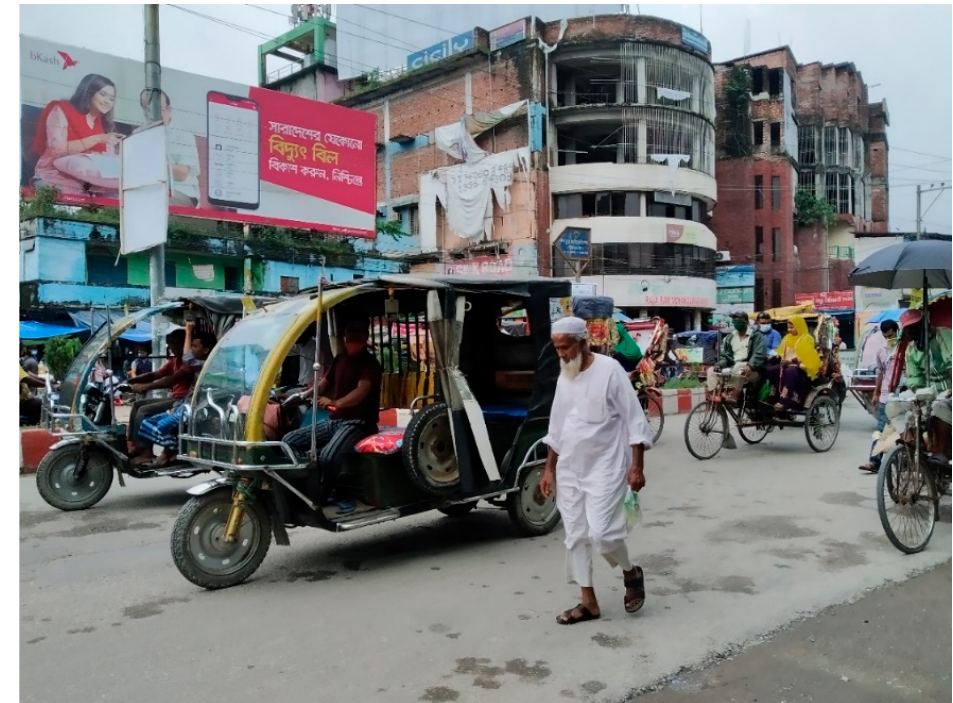
Figure 6. Easy-bikes and rickshaws on a major road in Rangpur